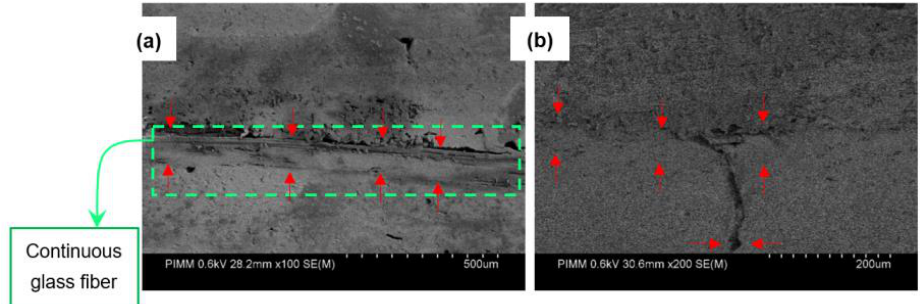
Figure 24. Fractography of the reinforced CF-PA6 with continuous glass fiber ( a ), and CF-PA6 ( b ) specimens [24].